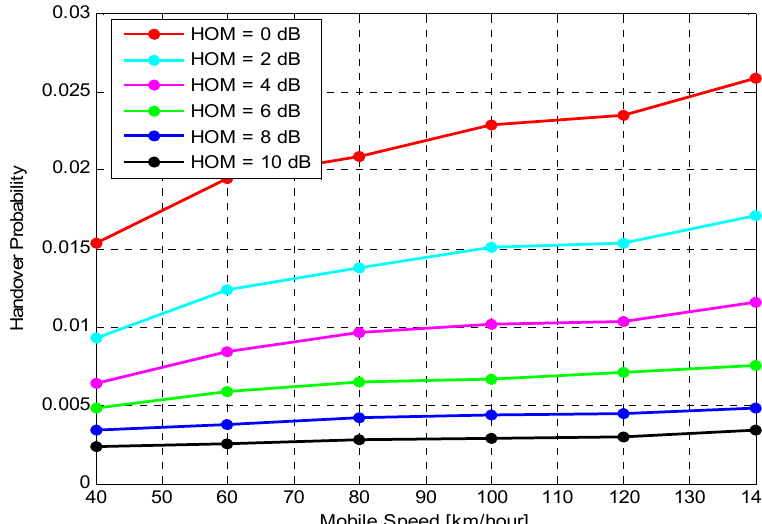
Figure 4. Handover probability versus UE speeds.